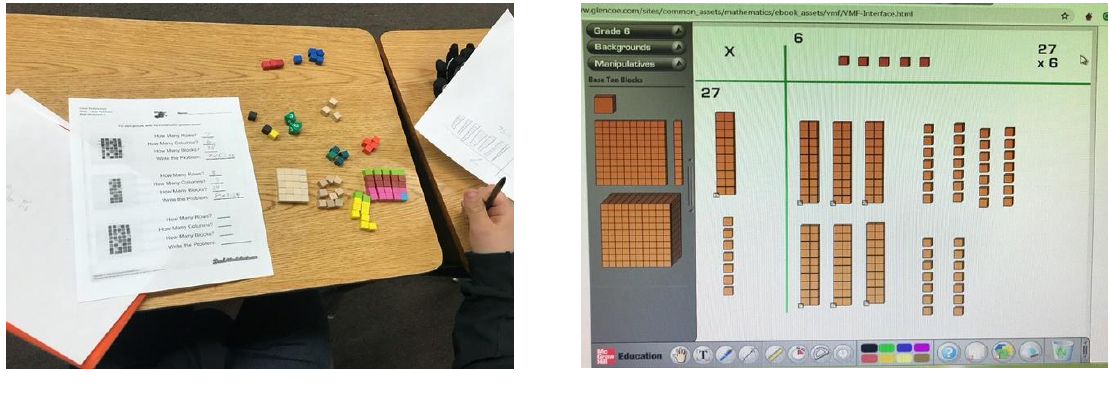
Concrete Manipulative Virtual